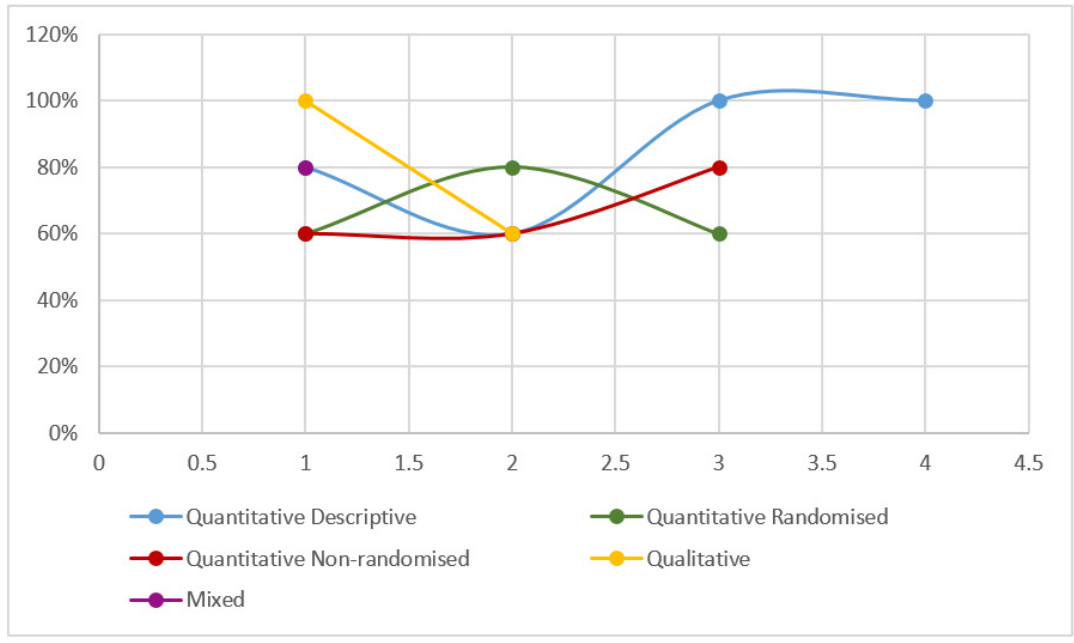
Figure 2. Methodological quality level (mixed method appraisal tool—MMAT), 2018. Source: Elaboration made by the authors, from Hong et al., 2018.